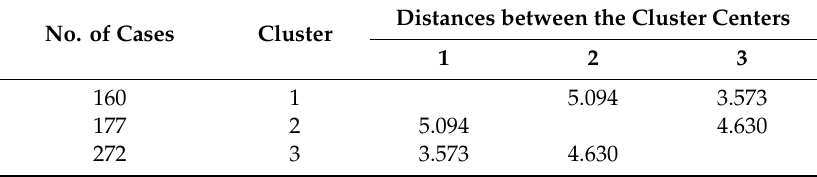
Table 2. Number of cases per cluster and distance between the cluster centers.